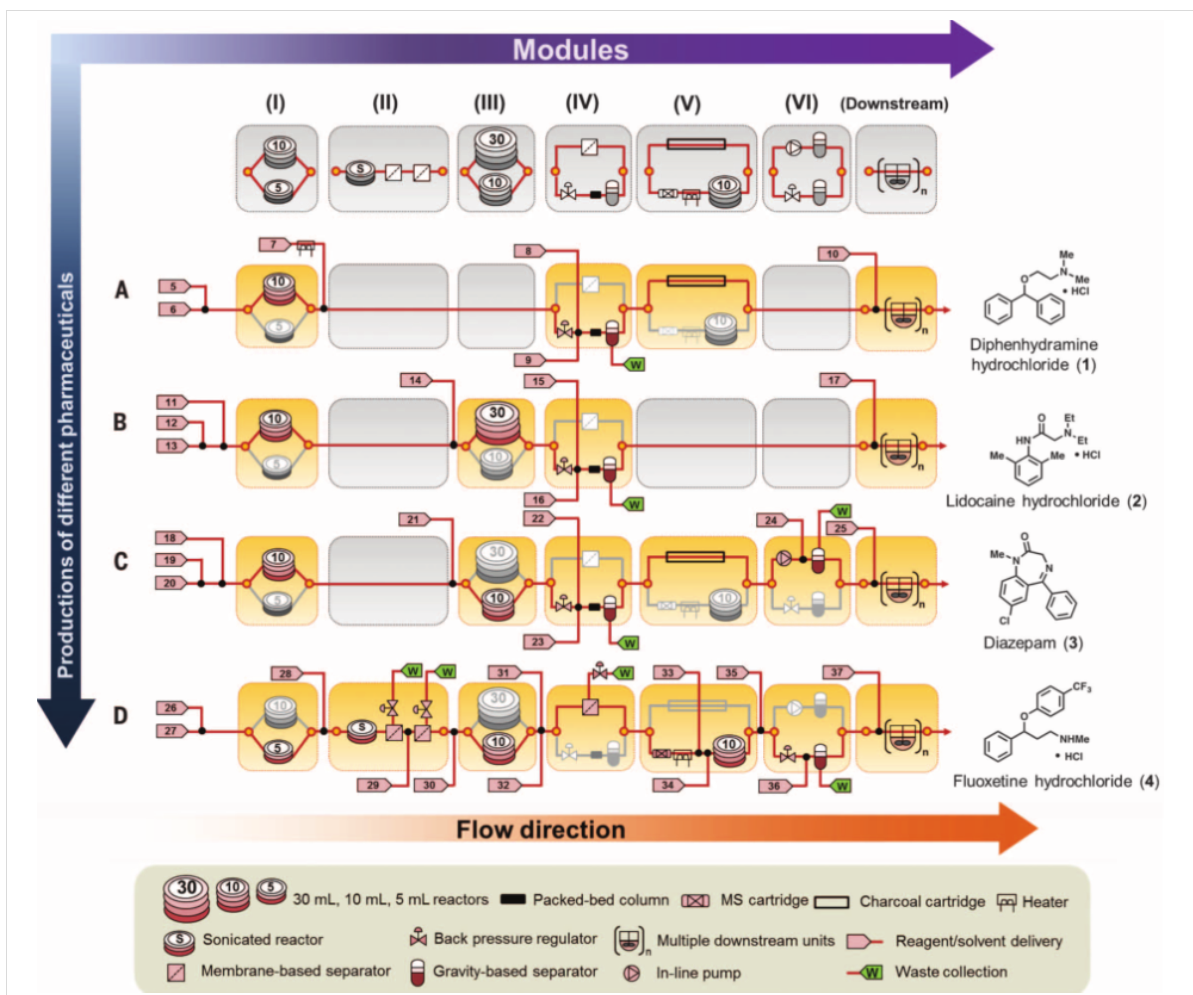
Figure 3: Reconfigurable modules and flowcharts for API synthesis. (Reproduced with permission from [85], copyright 2016 American Association for the Advancement of Science).